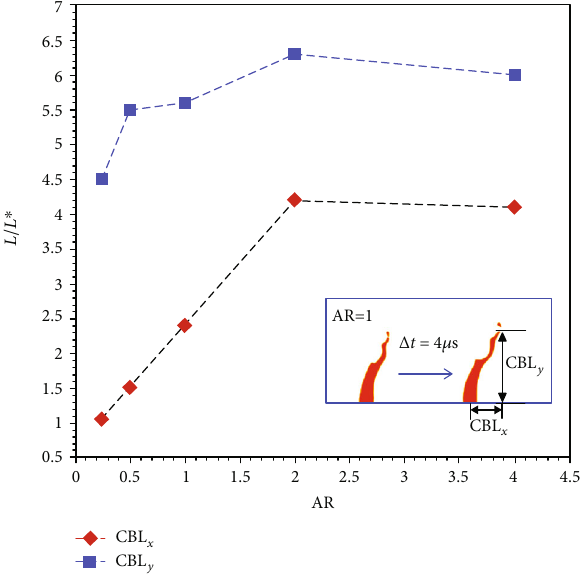
Figure 11: Liquid column breakup position and breakup